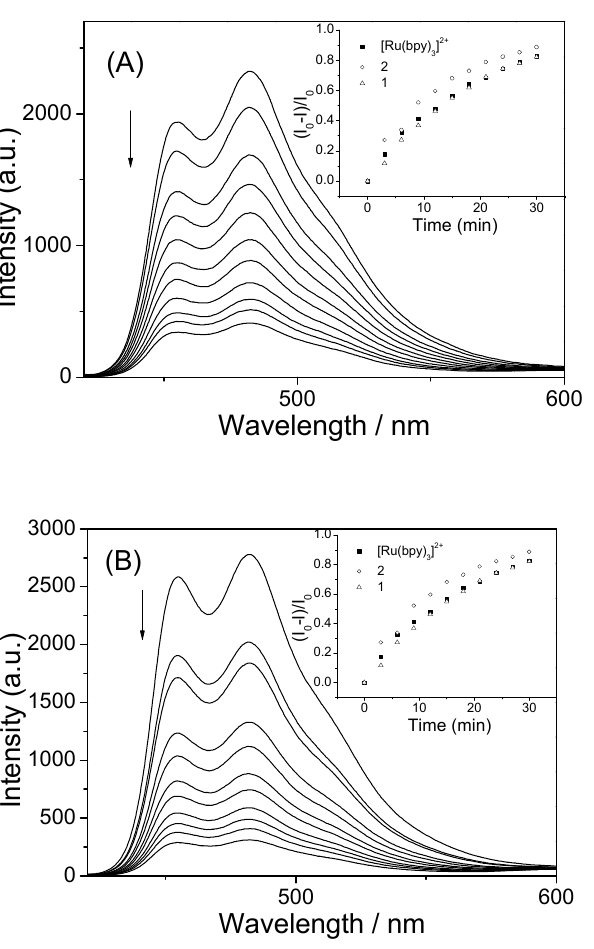
Figure 7. Fluorescence spectra of the DPBF (20 µ M) mixed with 1 ( A ) or 2 ( B ) (20 µ M) in methanol.